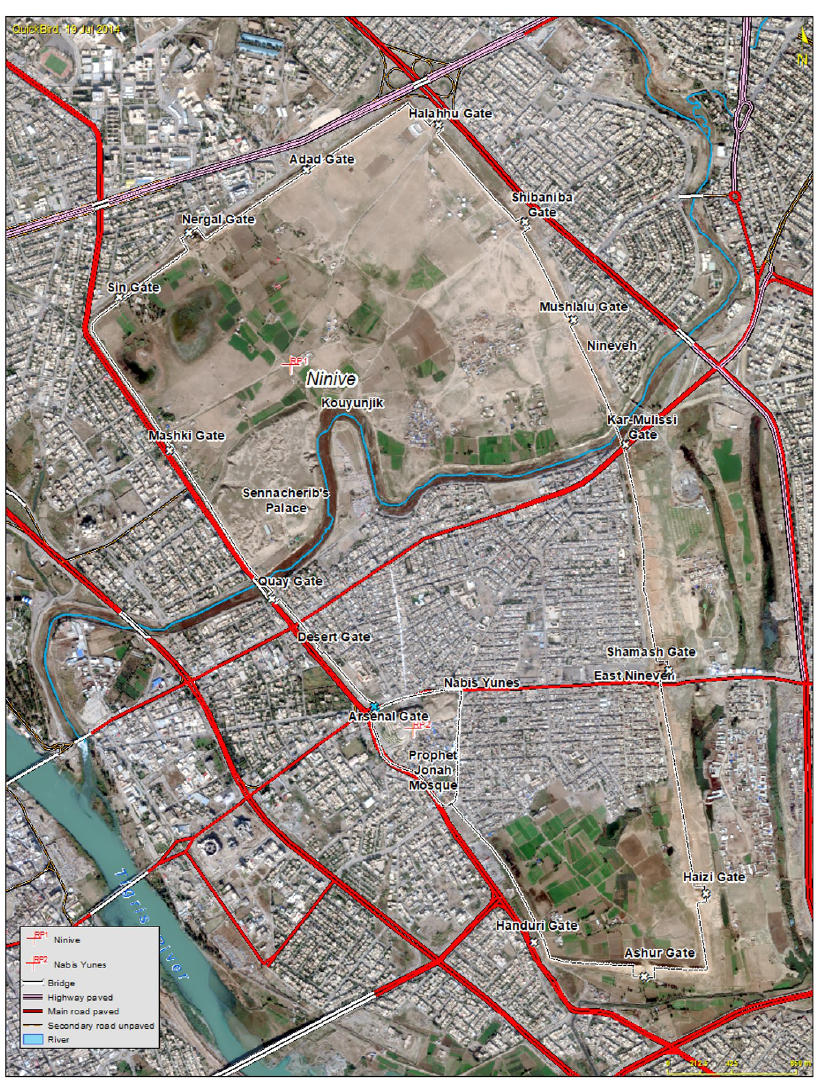
Figure 3. Overview of the main roads and waterways overlapped on walls and gates of Nineveh area—QuickBird, 19 July 2014 c (cid:13)